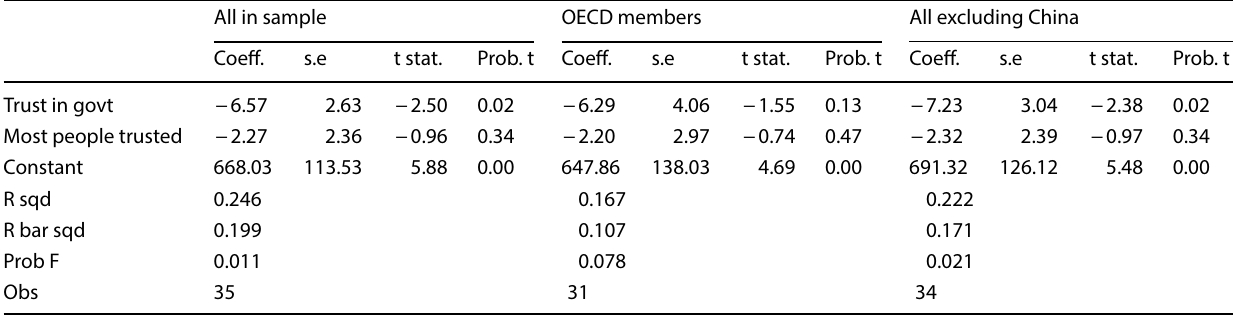
Table 7 Regression results for period 1